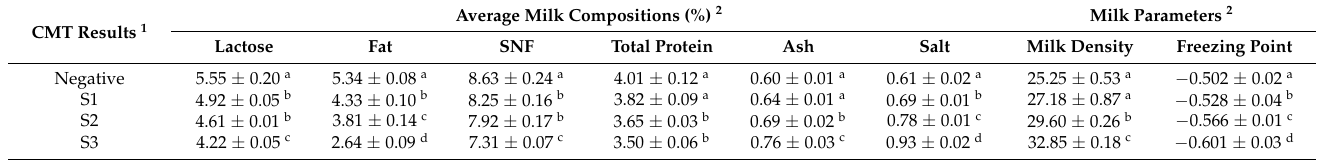
Table 3. CMT scores and milk compositions and some milk